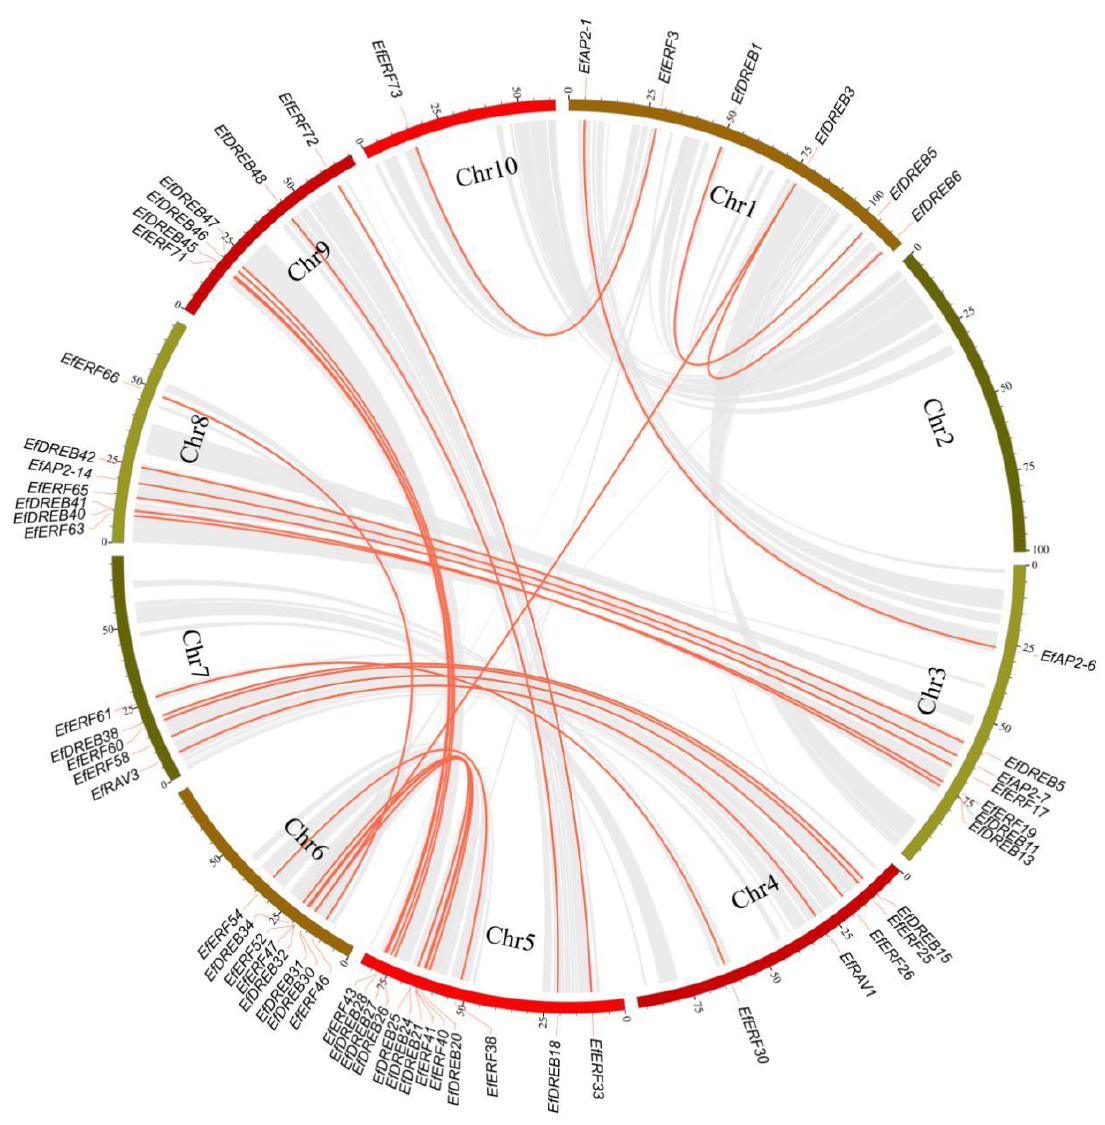
Figure 6. Interchromosomal segmental duplication gene pair analysis of the EfAP2/ERF family. A red line between two gene names indicates that they are segmental duplication gene pairs.